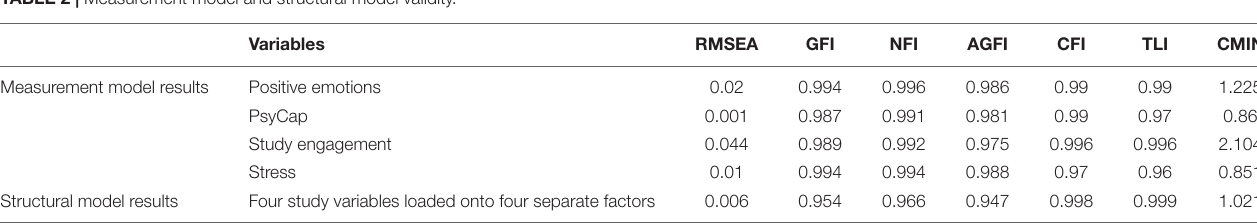
TABLE 2 | Measurement model and structural model